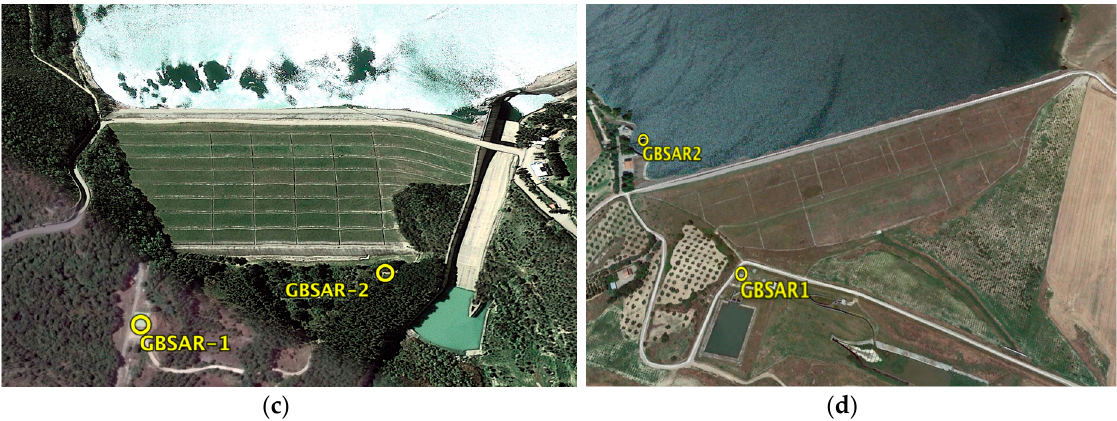
Figure 6. Google© snapshots of ( a ) Marana-Capacciotti dam on the Ofanto river, Cerignola; ( b ) Capaccio dam on the Celone stream, Lucera; ( c ) Occhito dam on the Fortore river, Carlantino and ( d ) San Pietro dam on the Osento stream, Aquilonia. The GBSAR installation sites are also shown.